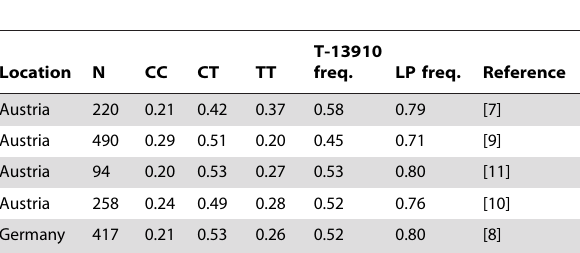
Table 4. Reported C/T-13910 allele frequencies in modern DNA studies of western Central